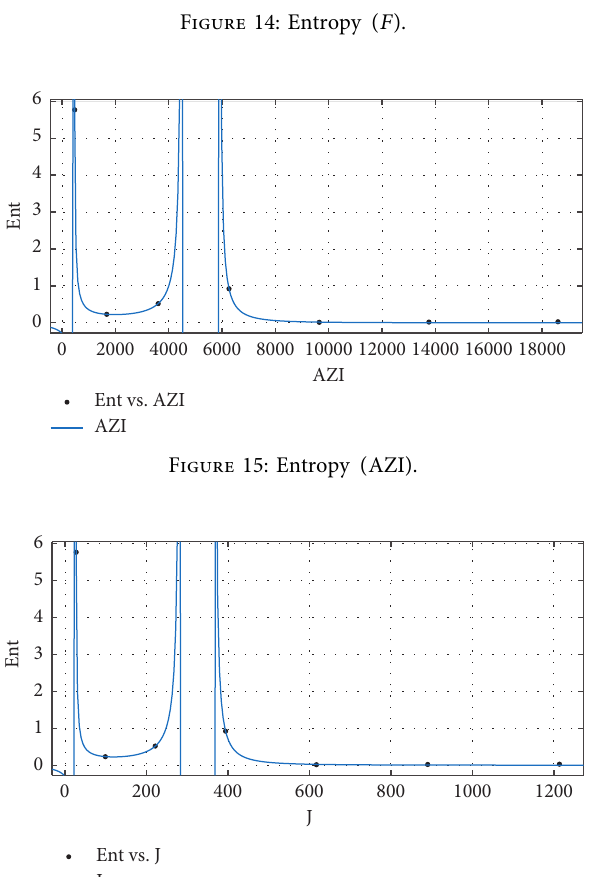
Figure 16: Entropy ( J )